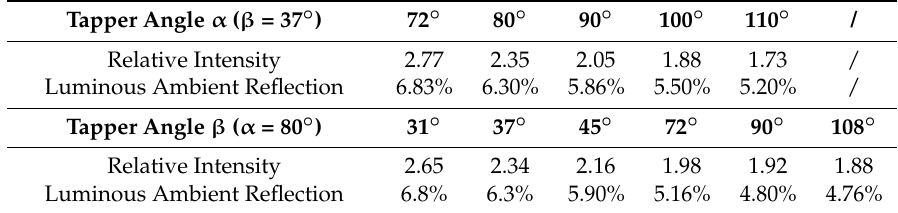
Figure 6. Relative light intensity and ambient light reflection as a function of taper angle ( a ) α when β = 37 ◦ , and ( b ) β when α = 80 ◦ . Table 1. Relative light intensity and luminous ambient reflection of device B.